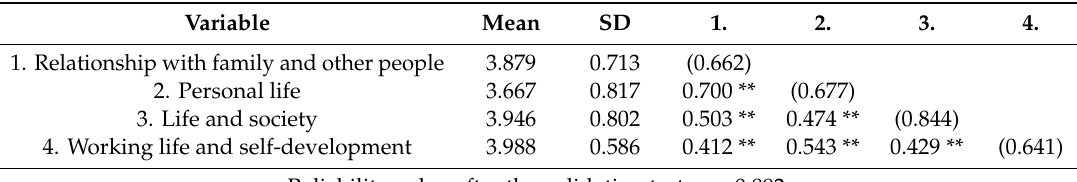
Table 4. Discriminant validity